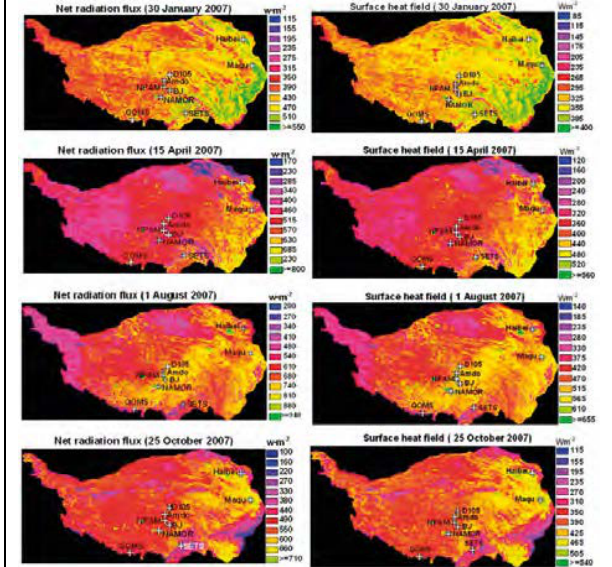
Figure 10. Radiative and convective fluxes at the land surface estimated using MODIS